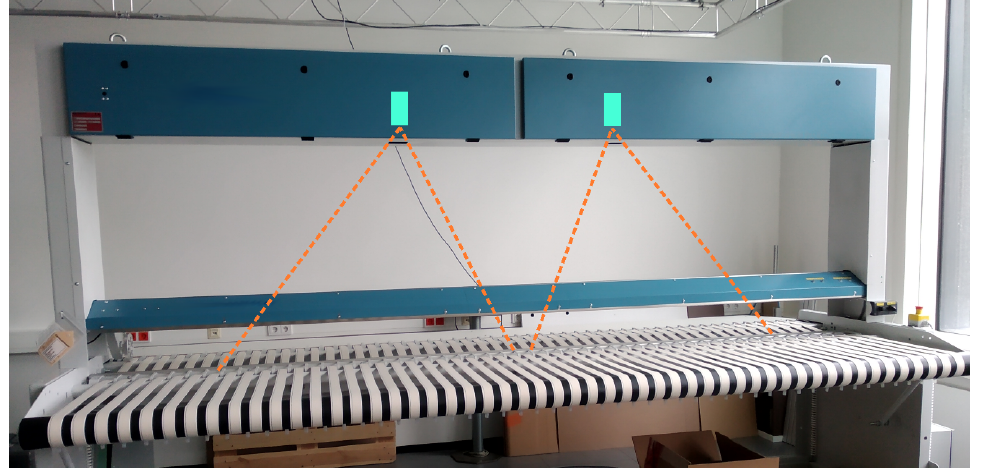
Figure 1. A photo of the image acquisition apparatus. The cyan rectangles show the positions of the line scan cameras. The dotted orange lines illustrate the field of view of each camera.